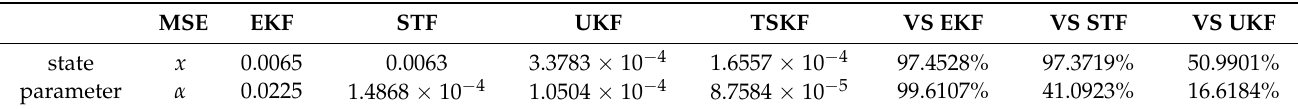
Table 2. Performance comparison of different algorithms.